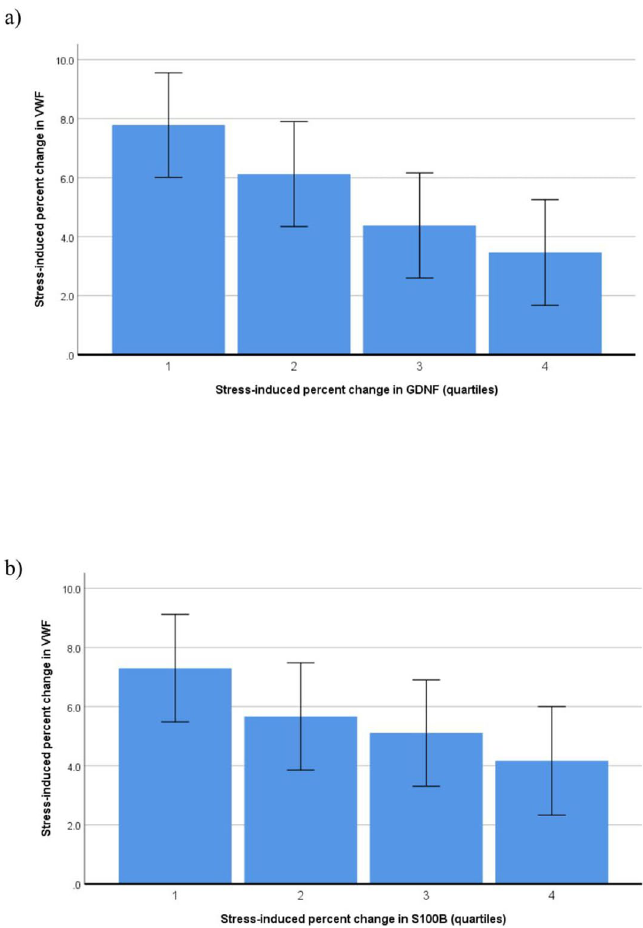
Figure 3. Fully adjusted significant associations between stress-induced percent changes in neurotrophins across quartiles (1 = lowest quartile, 4 = uppermost quartile) and stress-induced percent changes in von Willebrand factor (VWF). GDNF, glial cell-derived neurotrophic factor; S100B, S100 calcium-binding